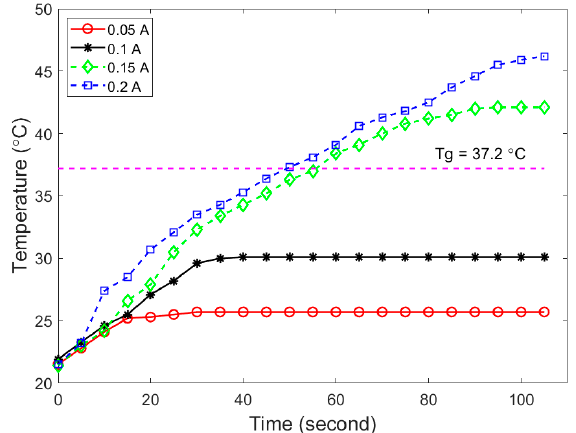
Figure 5. Surface temperature of the SMP foam specimen at various applied electric current magnitudes during the electrical resistance heating.